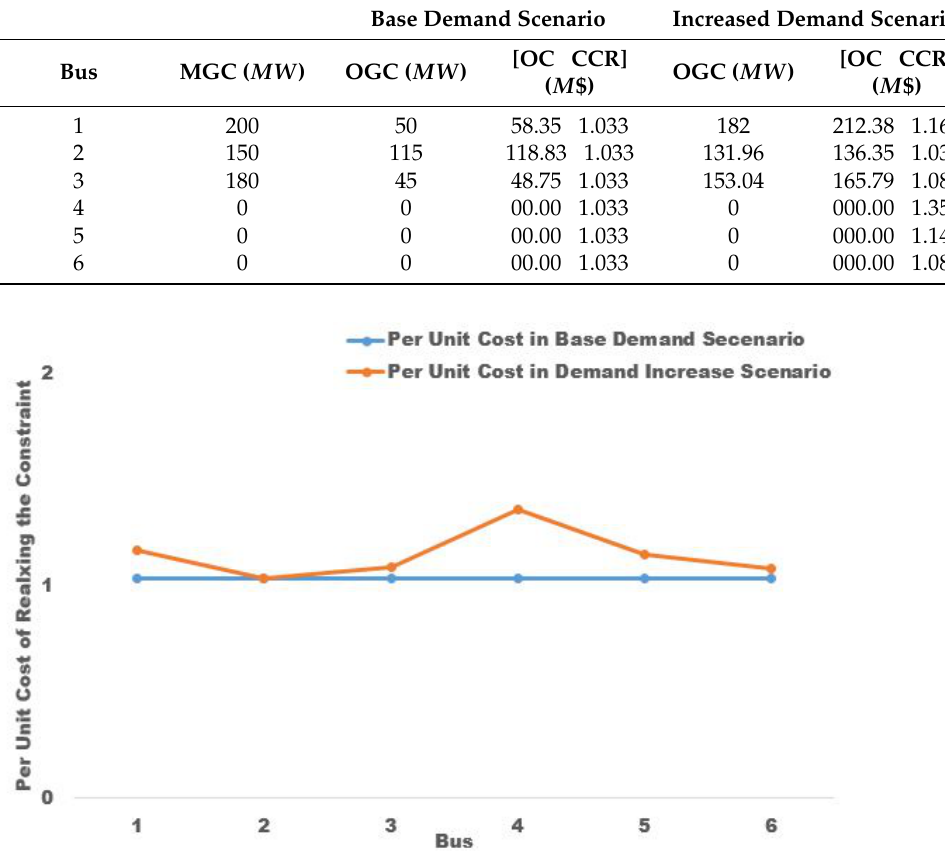
Figure 2. The 6-bus system’s per unit cost of relaxing the constraint in base and increased demand